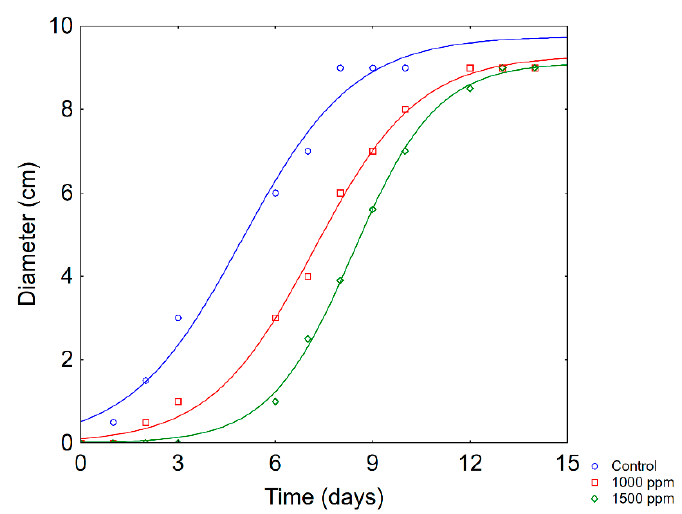
Figure 4. Growth kinetic of F. oxysporum on plates as a function of propolis concentration; the points represent the average of three determinations. Lines are the best fit through Dantigny model.